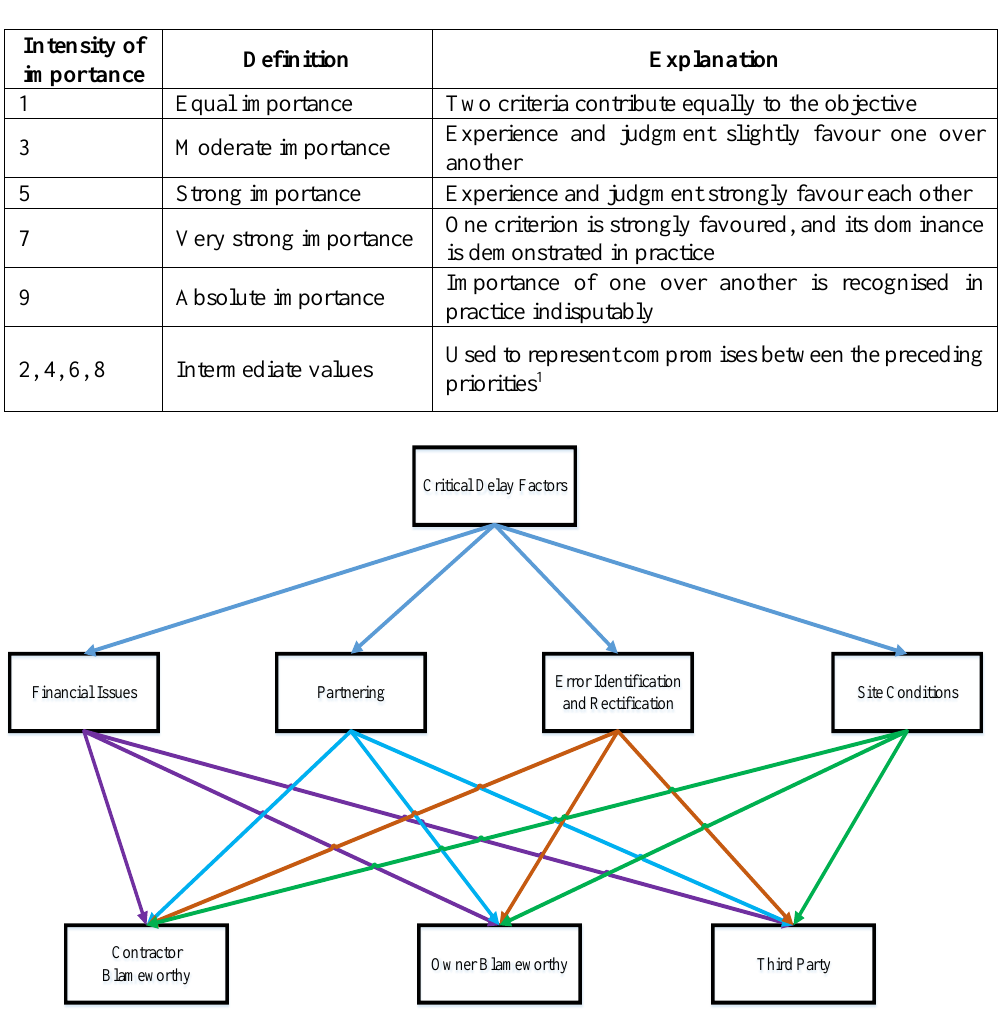
Table 1. Scale for Pairwise Comparison (Source: Saaty 2008, p. 88)